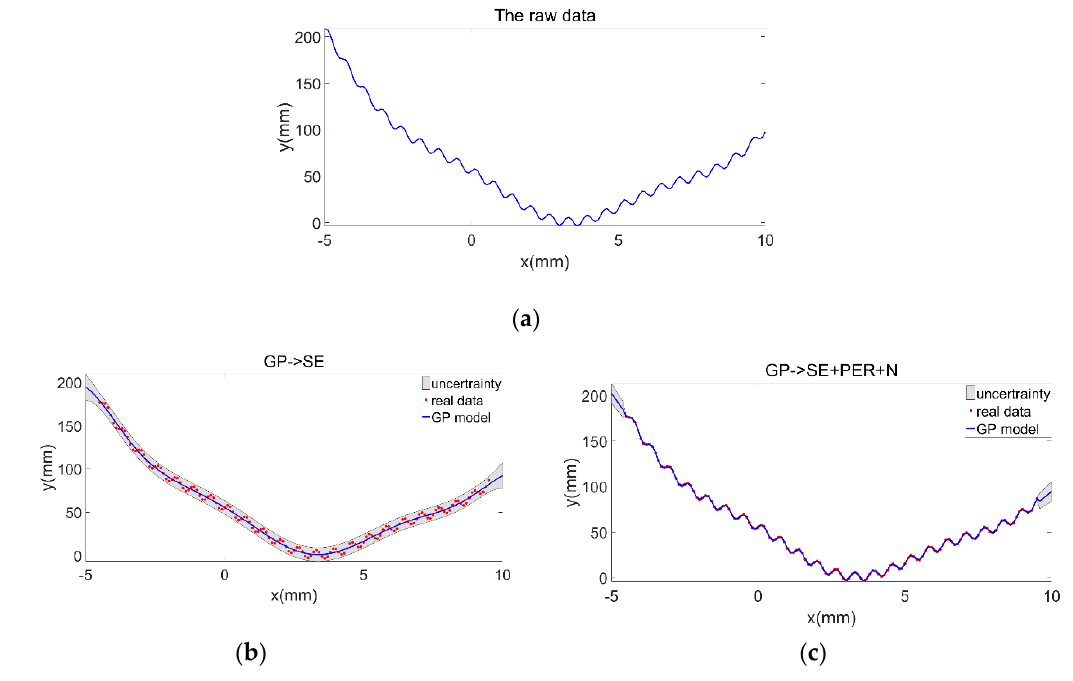
Figure 3. Gaussian process (GP) modeling of a multifeatured curve. ( a ) Raw data model of the curve; curve model after GP regression (GPR) with ( b ) square exponential (SE), and ( c ) SE + periodic (PER) + Noise.